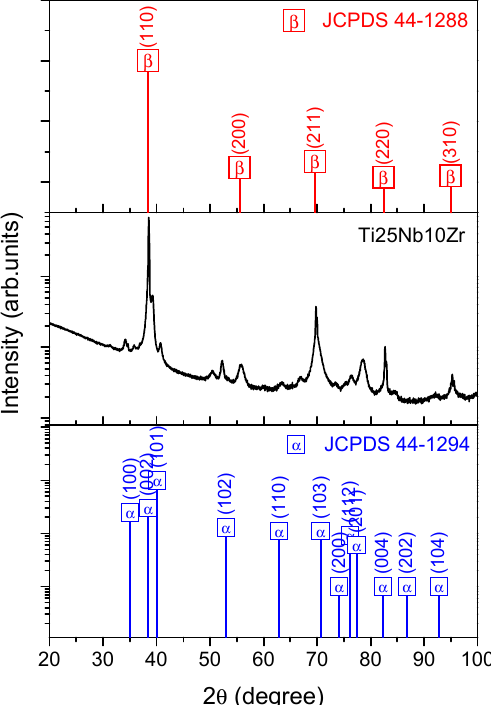
Figure 1. XRD diffraction pattern of Ti25Nb10Zr alloy and JCPDS files No. 44-1294 ( α ” phase) and 44-1288 ( β phase).